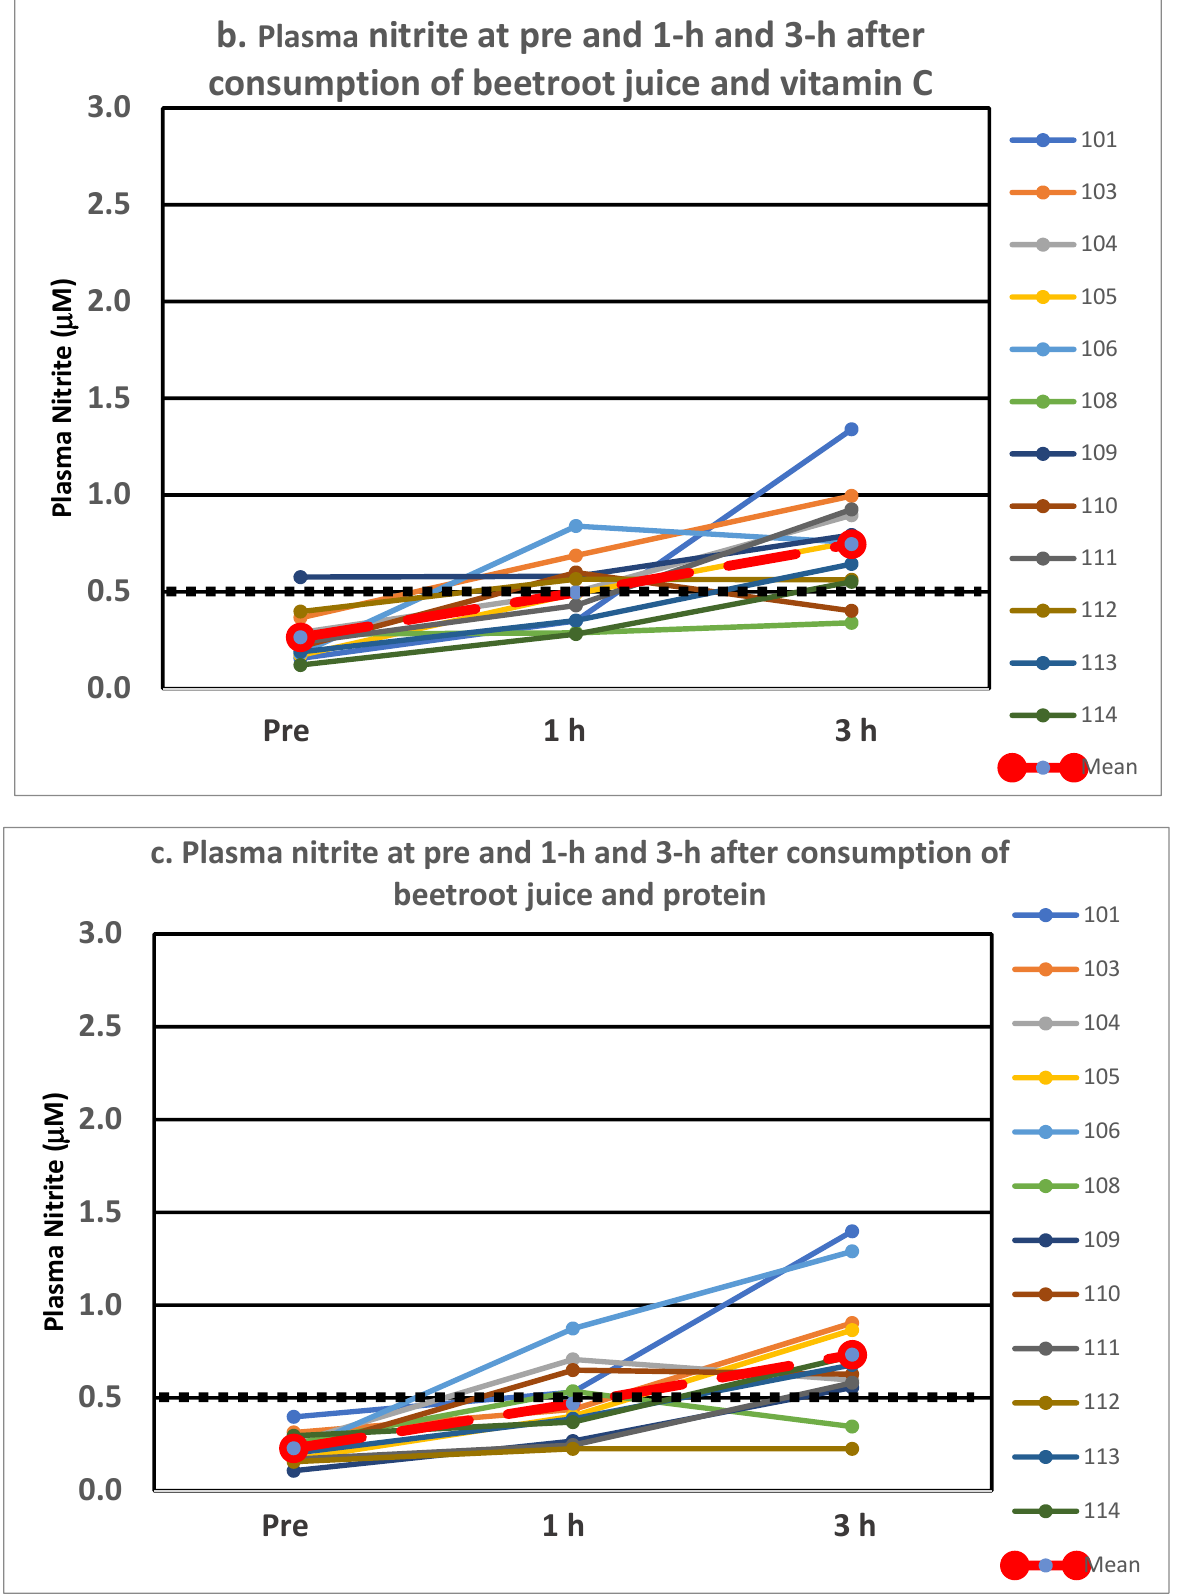
Figure 1. ( a – c ). Individual responses in plasma nitrite following consumption of beetroot juice alone ( a ), with vitamin C ( b ) and with protein ( c ). The treatment mean is depicted in the large dashed red line and the black dotted line at 0.5 mM line shows the level marking responders vs. non-responders.